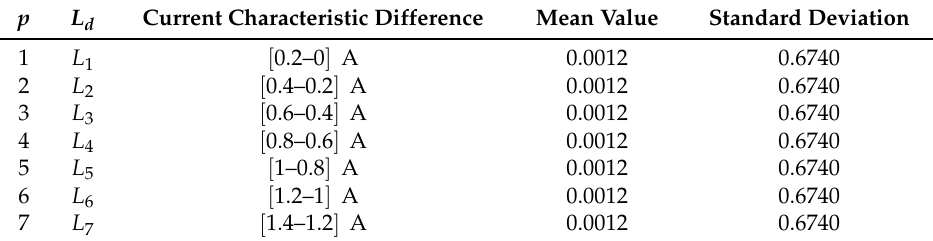
Table 2. Calculated difference characteristics L p with mean and standard deviation